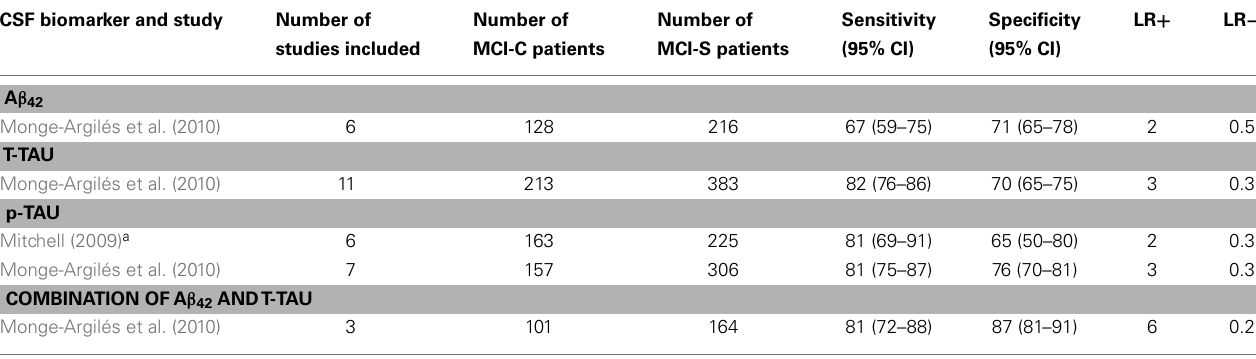
Table 4 | Systematic reviews with meta-analyses (MCI-C vs. MCI-S): sensitivity and specificity